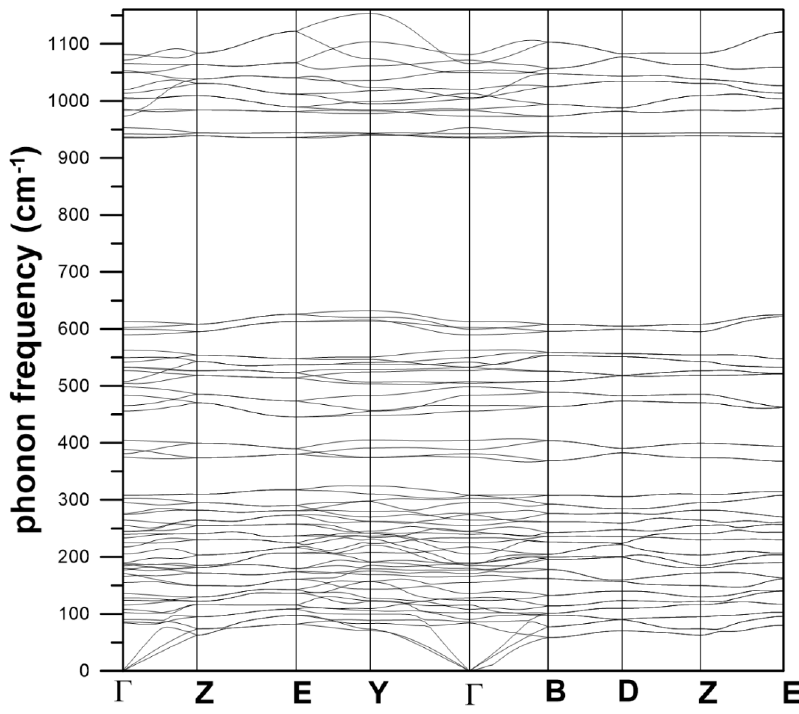
Figure 8. Phonon dispersion along the Brillouin zone of the of monazite-type GdPO 4.